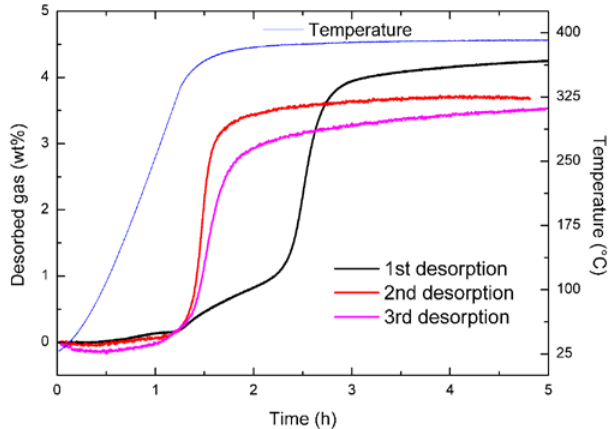
Figure 5. Hydrogen release in the first three desorption during cycling of S2 in a Sieverts-type apparatus. The hydrogen pressure is 5–10 bar.